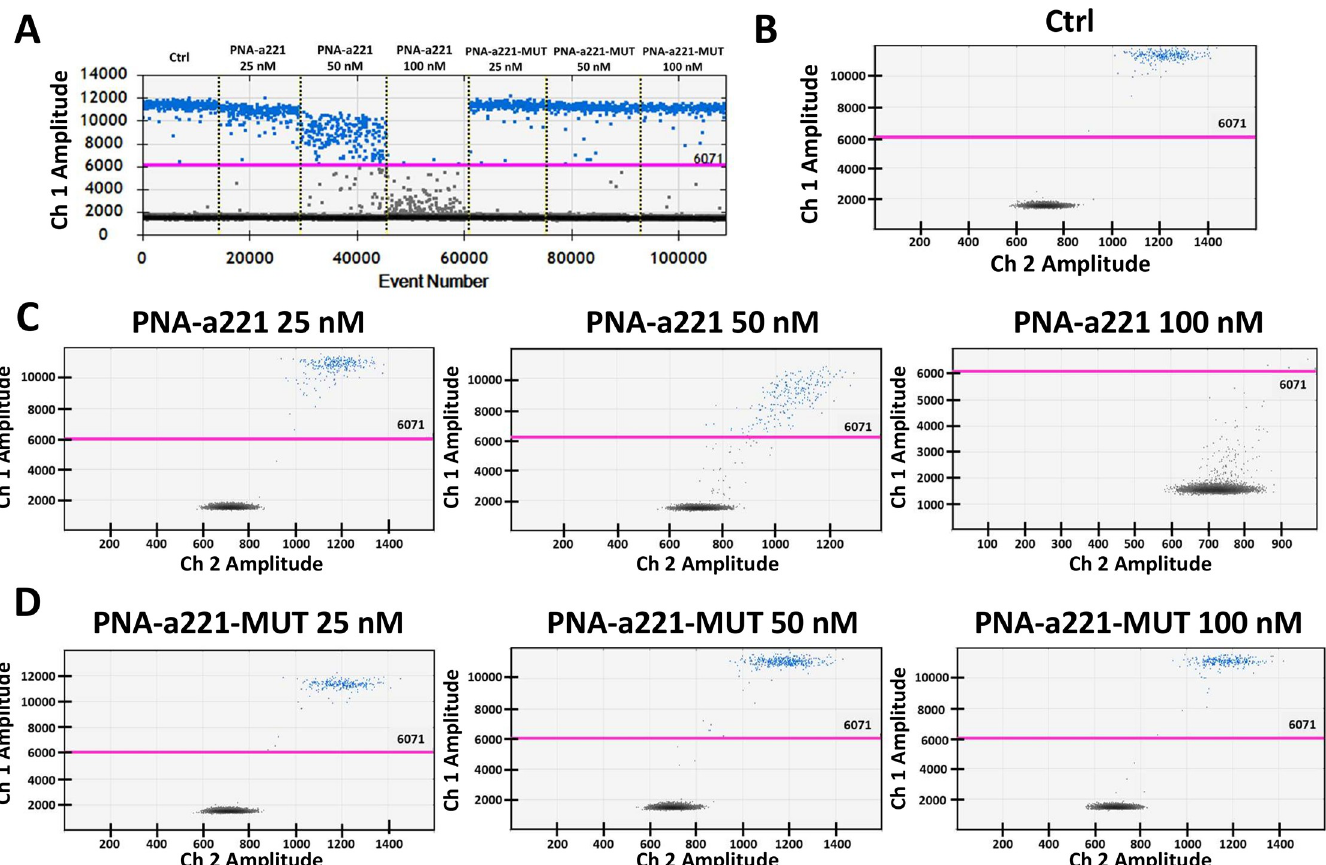
Fig 5. Effects of R8-PNA-a221 on miR-221-3p sequence detection by RT-ddPCR. A. 1D RT-ddPCR plot obtained after the addition of incremental concentration of R8-PNA-a221 or R8-PNA-a221-MUT to the reaction mix. B. miR-221-3p content in 1:50 diluted cDNA obtained from U251 cells: 2D plots. C. miR-221-3p content detected after the addition of incremental R8-PNA-a221concentrations. D. miR-221-3p content detected after the addition of incremental R8-PNA-a221-MUT